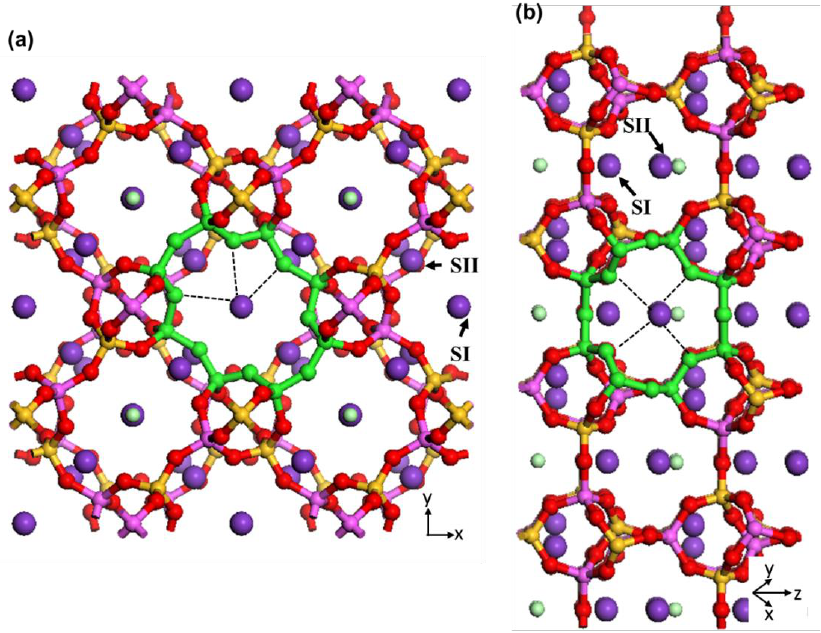
Figure 7. Illustrations of SI and SII sites for extra-framework K in zeolite N supercells along ( a ) [001] and ( b ) [110] crystallographic directions. The 8-membered ring pore openings in each channel direction are highlighted with green colour. The black dashed lines indicate the interaction of potassium cations in sites SI and SII with framework oxygen atoms. Atoms are coloured as silicon = yellow, aluminium = pink, oxygen = red, potassium = purple and chloride = light green.